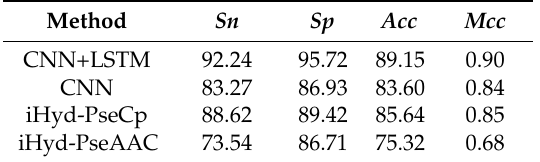
Table 3. A comparison of predictors for identifying hydroxyproline sites on Dataset 3.